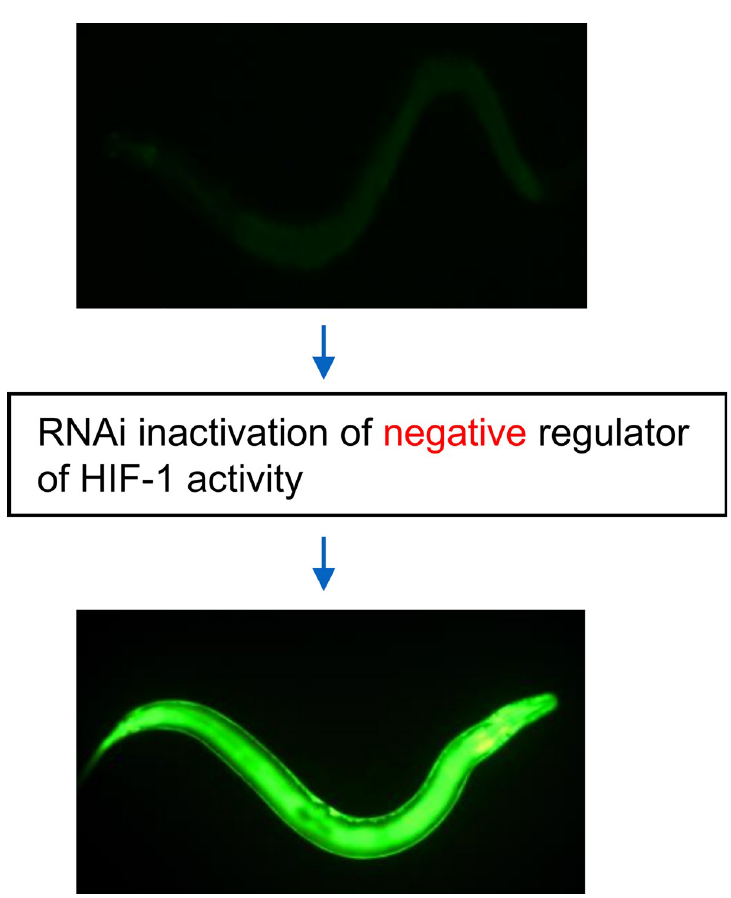
Fig 1. Genome-wide RNAi screen to identify negative regulators of HIF-1-mediated gene expression. Illustration of screen design. C . elegans expressing the Pnhr-57 ::GFP reporter were fed bacteria expressing gene-specific RNAi. Prior studies had shown that this reporter is induced by hypoxia and is positively regulated by the HIF-1 transcription factor. In controls (photo at the top), animals exhibited a low level of fluorescence, while RNAi treatments that increased expression of the reporter resulted in high levels of